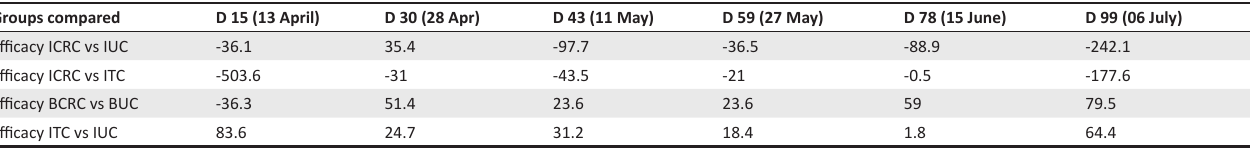
Efficacy ITC vs IUC